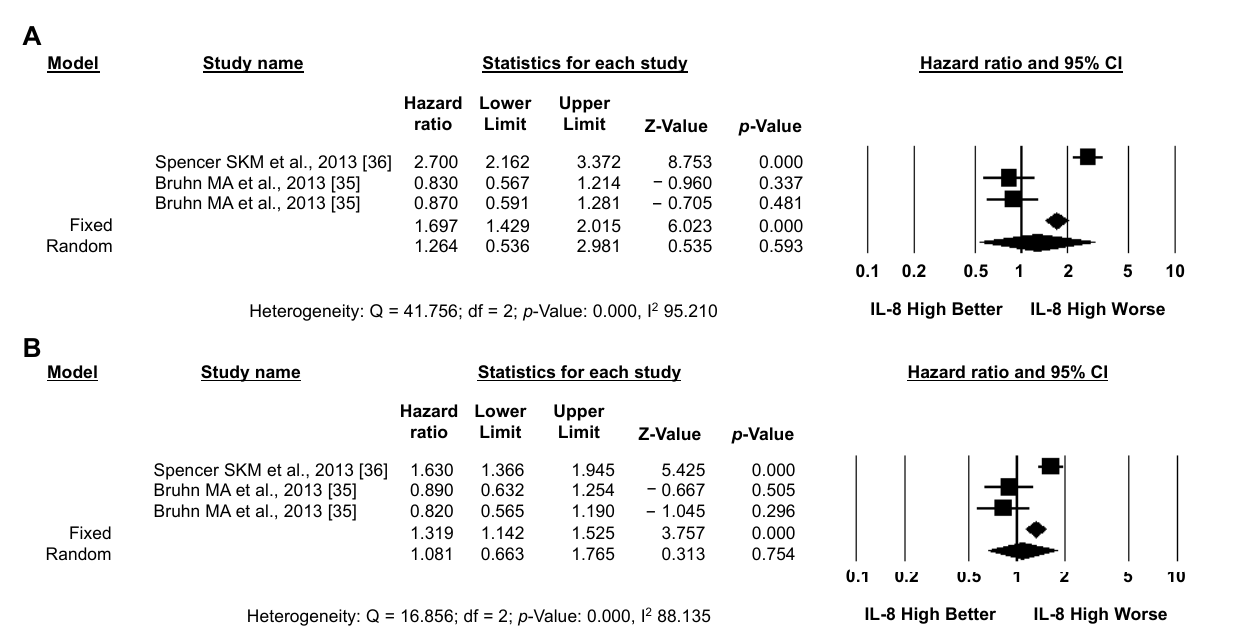
Figure 7. IL-8 levels do not correlate with the clinical outcome of systemic treatment with/without anti-angiogenic agents. Meta-analysis of the HR for the association of the OS ( A ) or PFS ( B ) source and patients who had received chemotherapy with or without anti-angiogenic agents.